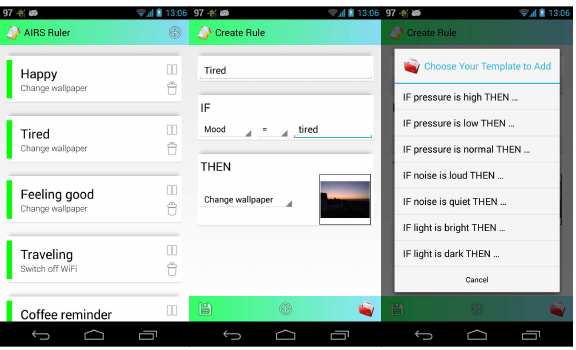
Figure 7 . Rule definition in AIRS Ruler (a) list of rules (b) individual rule (c) templates for